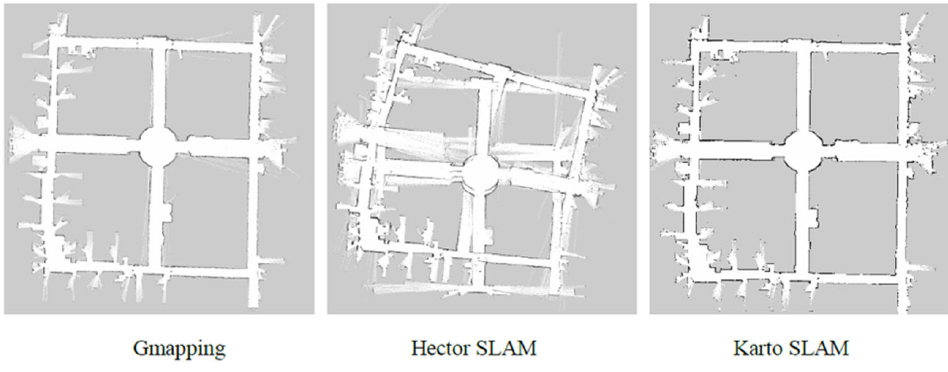
Figure 8. Comparison of three SLAM algorithms.